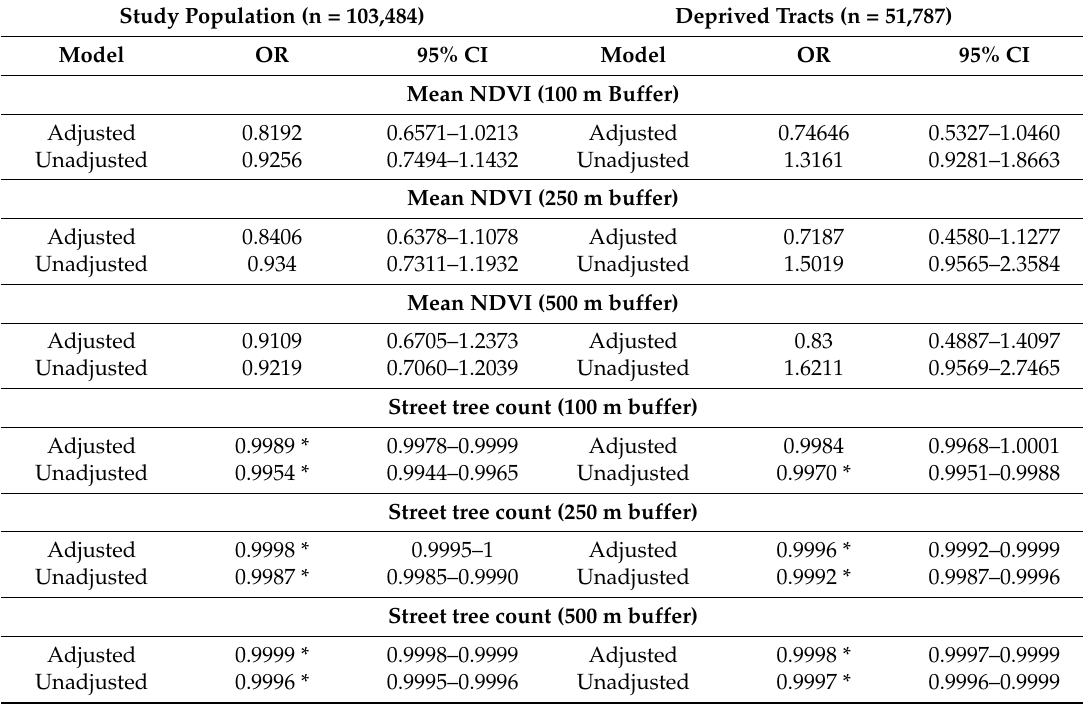
Table 6. Mixed-effects logistic regression results for the odds of preterm